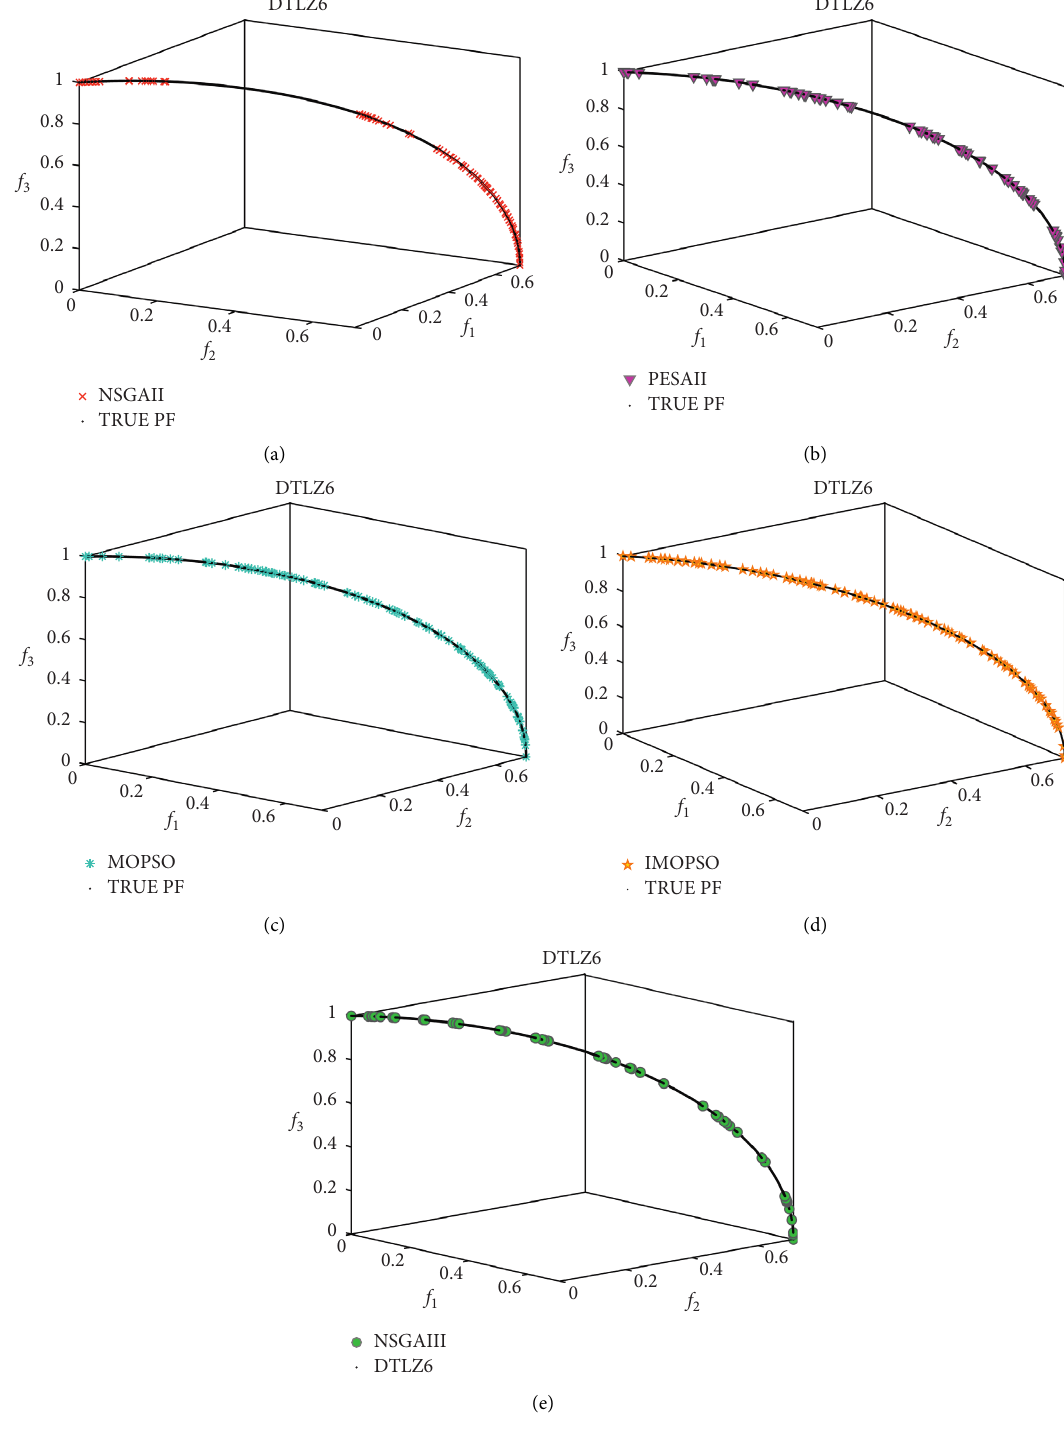
Figure 12: DTLZ6 test